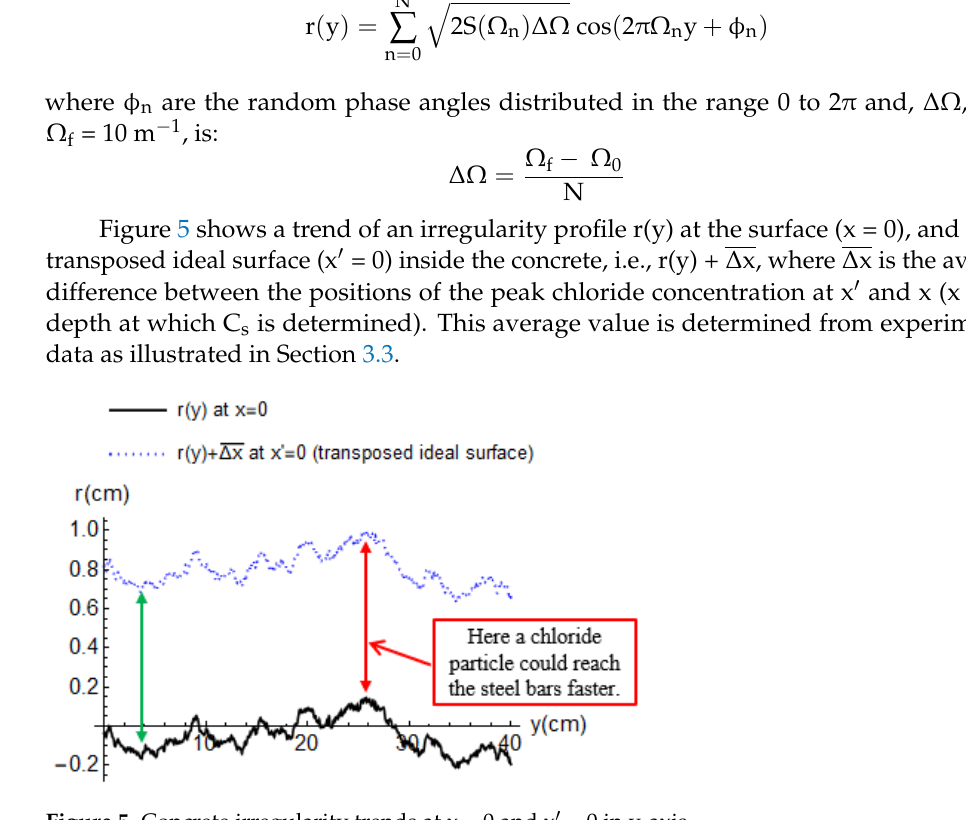
Figure 5. Concrete irregularity trends at x = 0 and x’ = 0 in